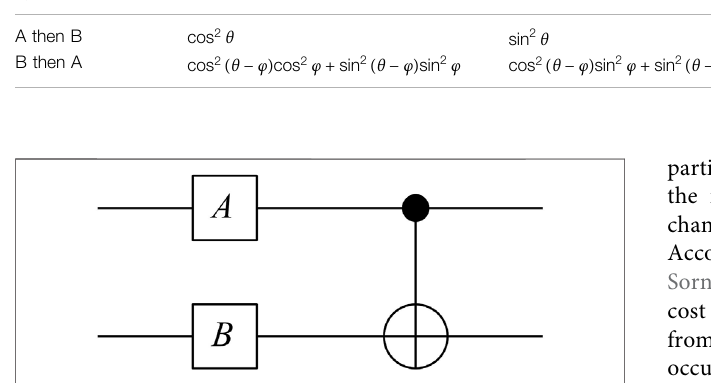
TABLE 1 | Probabilities of the possible outcomes in the order effect model. Question order